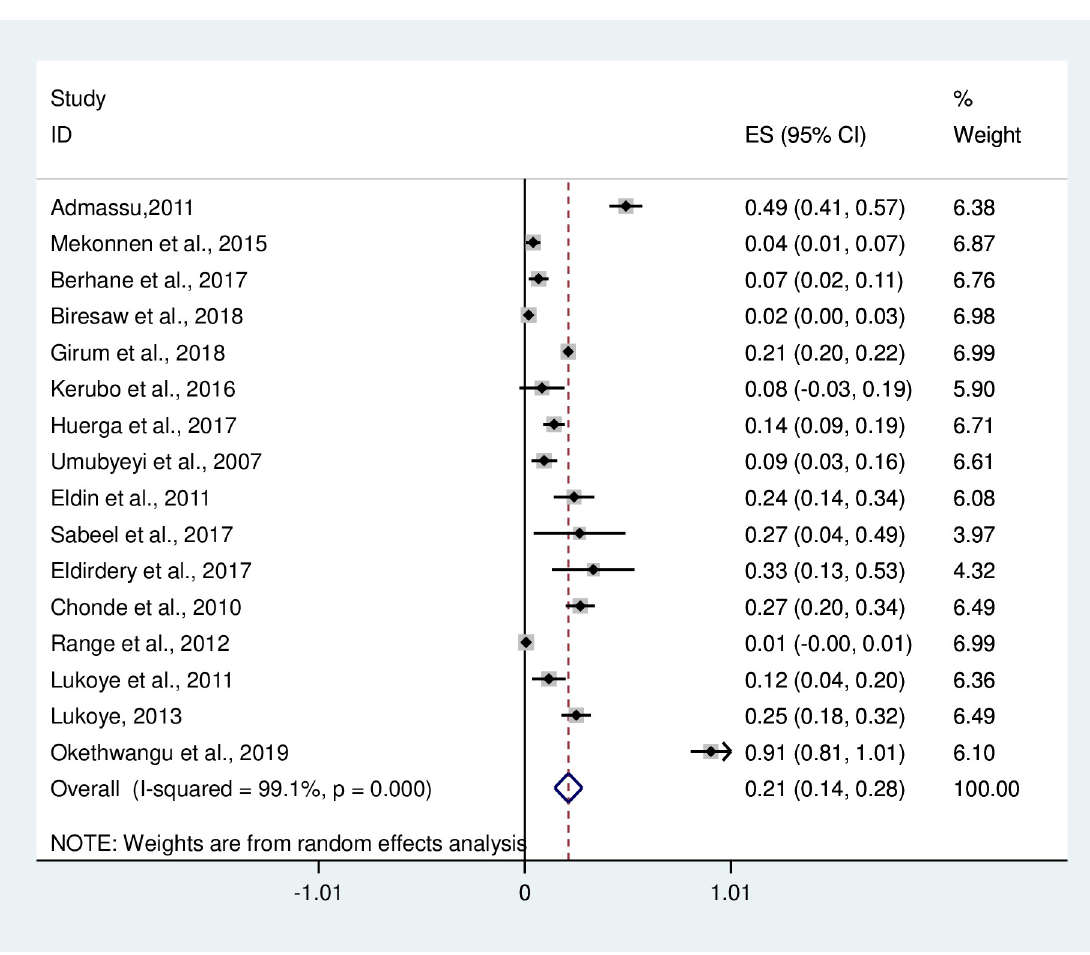
Fig 5. Forest plot showing the prevalence of MDR-TB among previously treated TB cases in East Africa, 2007 to 2019. Abbreviation: ES: Effect size; CI: Confidence